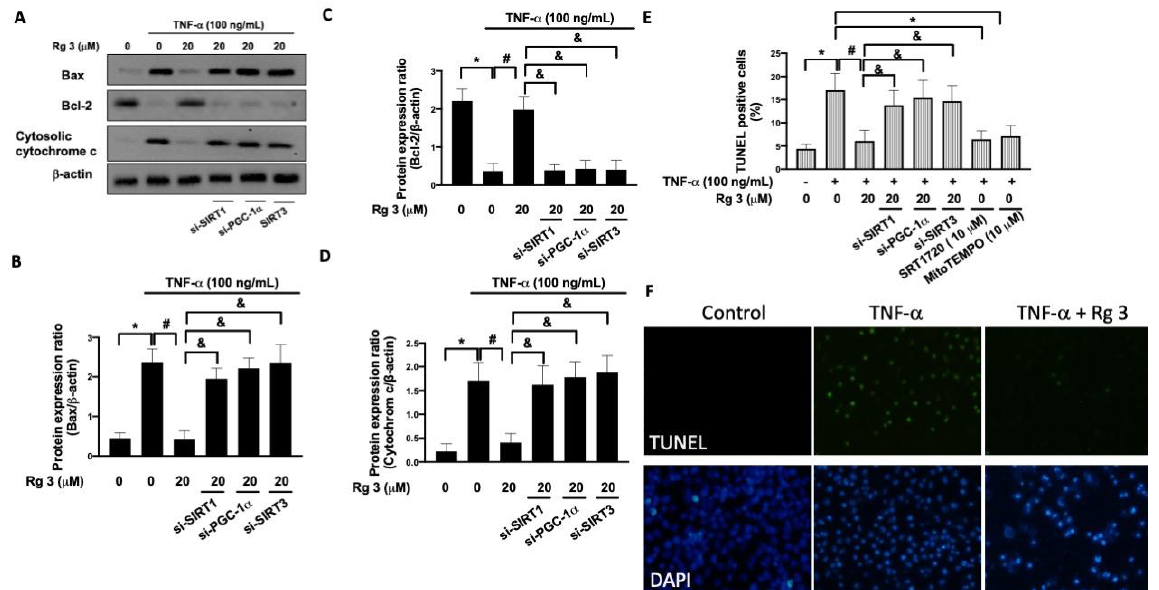
Figure 4. Rg3 protects against TNF- α -caused apoptosis in human chondrocytes through SIRT1/PGC-1/SIRT3 pathway. Representative Western blot images ( A ) and relative densitometric bar graphs of Bax ( B ), Bcl-2 ( C ), and cytochrome c ( D ) in chondrocytes stimulated to 100 ng/mL TNF- α for 24 h were shown. In some cases, cells were transfected with siRNAs 48 h before treatment with Rg3. TUNEL assay was used for the investigation of apoptotic cells using flow cytometry ( E ) and the fluorescent microscope ( F ). The selective activator SIRT1, SRT1720, and the inhibitor of mitochondrial ROS, mitoTEMPO, were pre-treated 2 h before TNF- α -stimulation. (* indicating p < 0.05 compared with the control group; # indicating p < 0.05 compared to TNF- α -stimulated cells; & indicating p < 0.05 compared to TNF- α plus Rg3 cells).